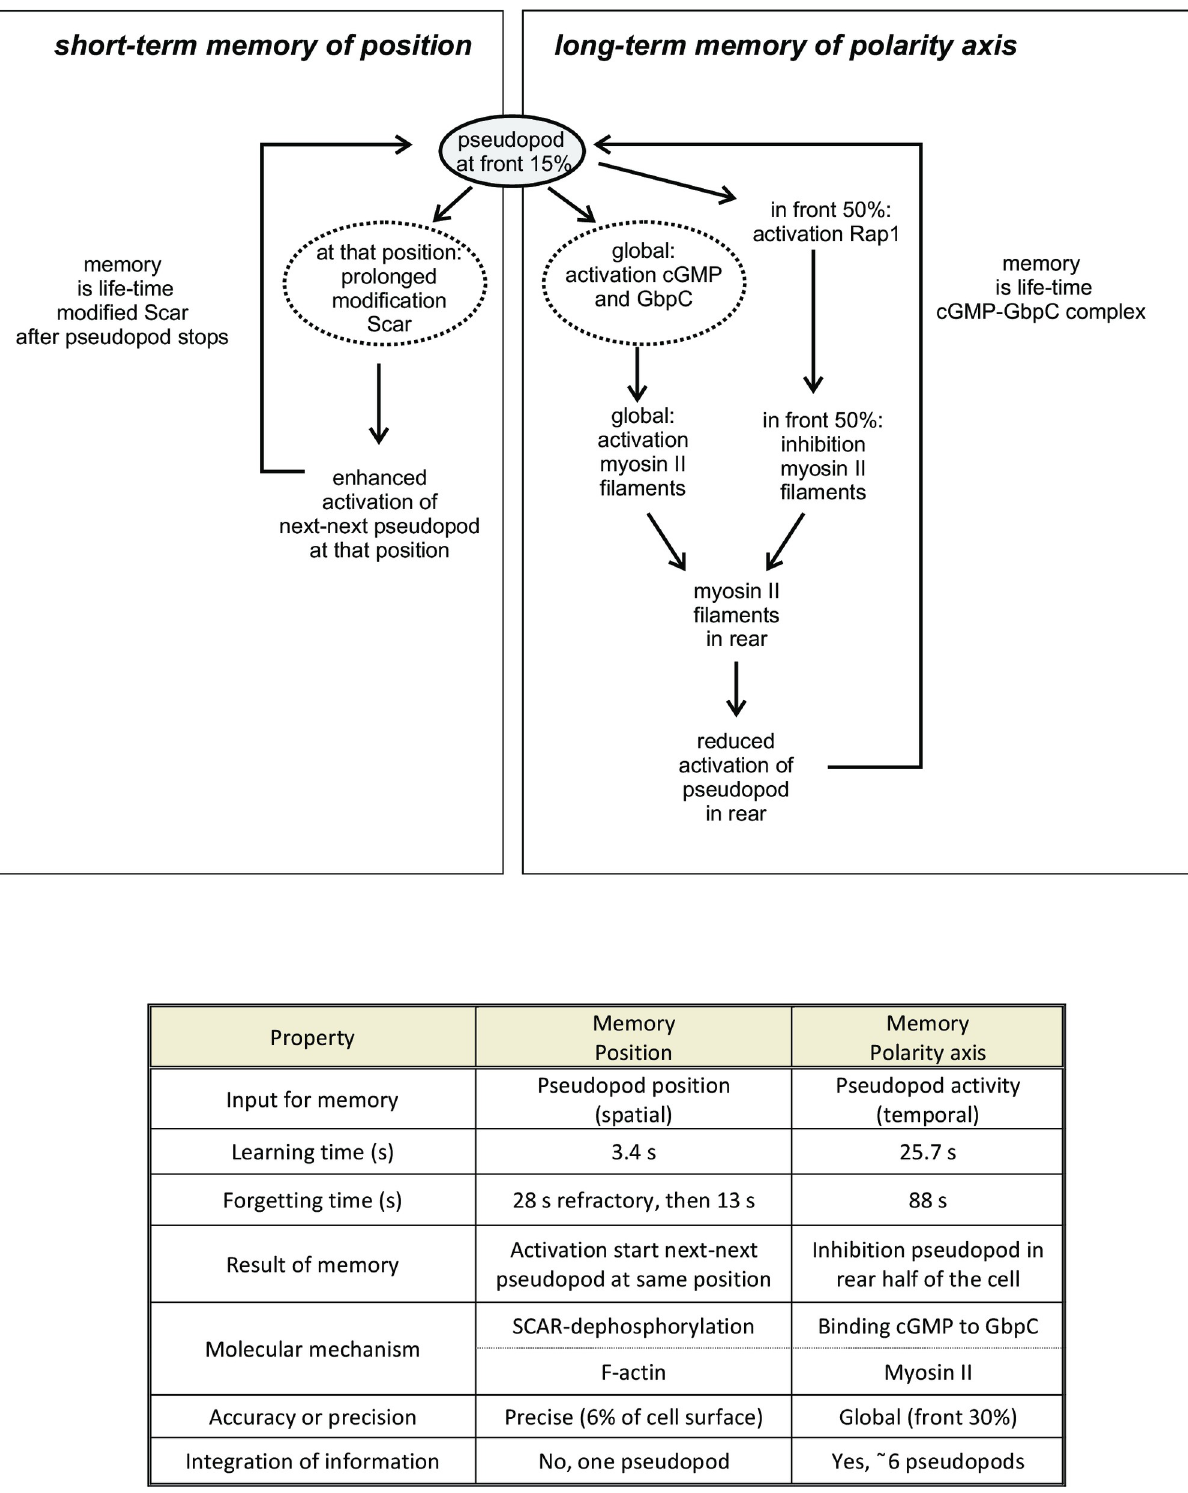
PLOS ONE | https://doi.org/10.1371/journal.pone.0246345 February 11,